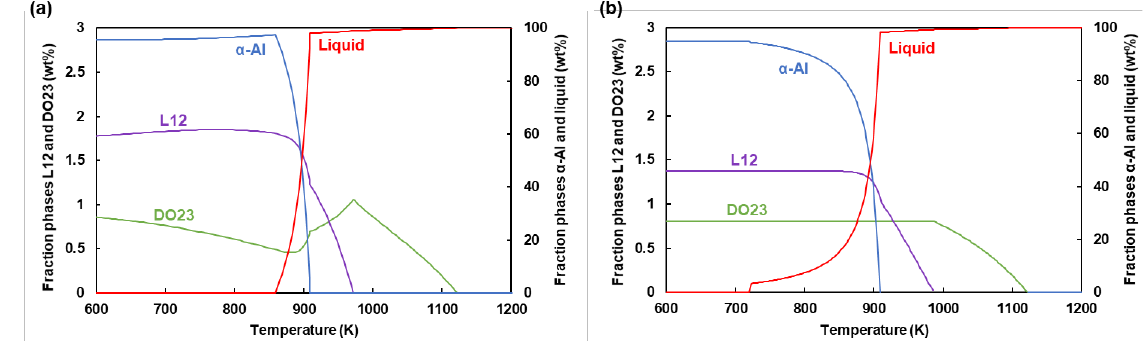
Figure 1. Fraction of various phases versus temperature during ( a ) heating and ( b ) cooling.